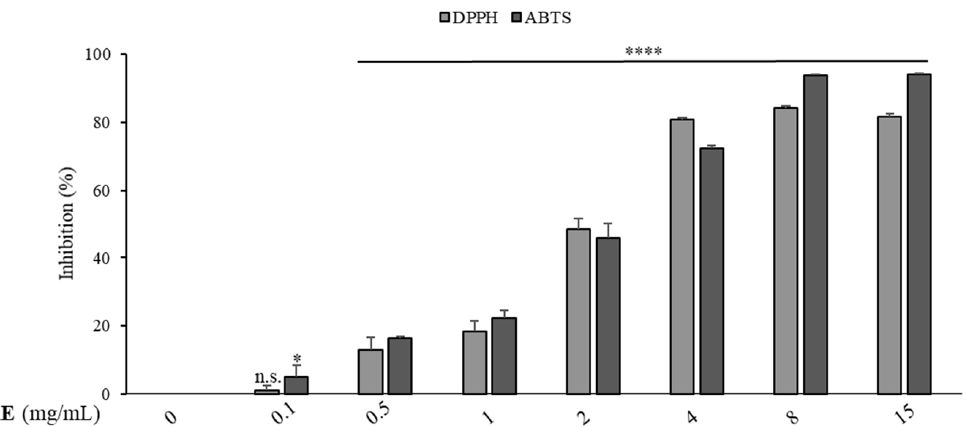
Figure 2. Changes in %I DPPH and %I ABTS of AE at different concentrations. Extract I% vs. initial concentration of ABTS or DPPH (0). The values represent the means ± SDs of three different experiments, each performed in triplicate. n.s.: not significant; * p < 0.05; **** p <